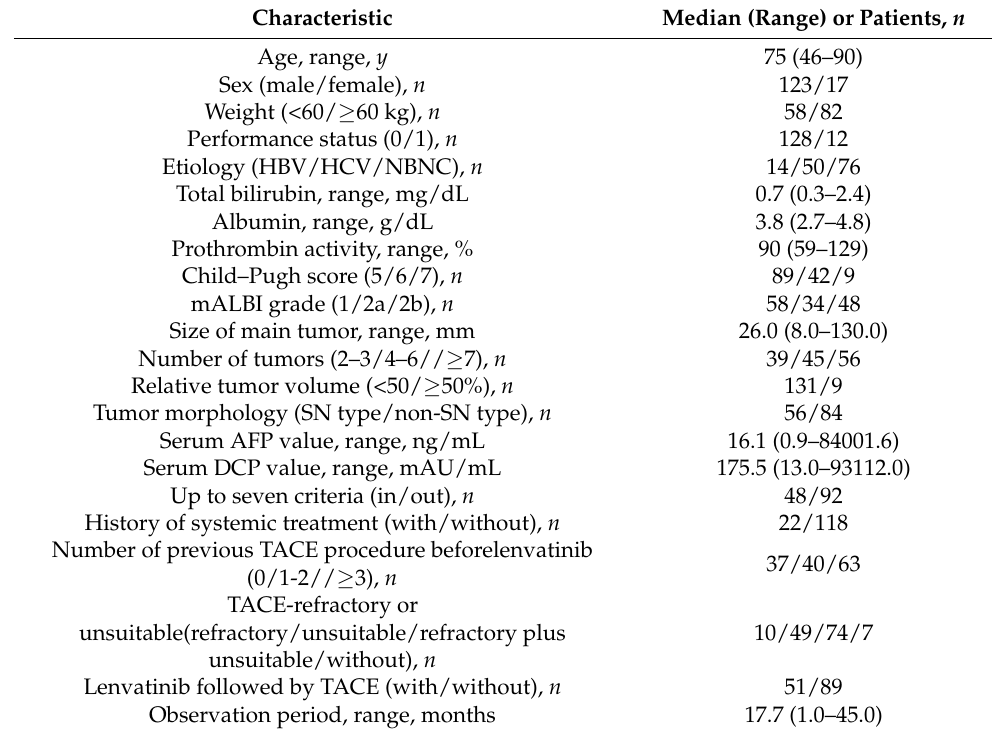
Table 1. Clinical characteristics at the initiation of lenvatinib ( n = 140).